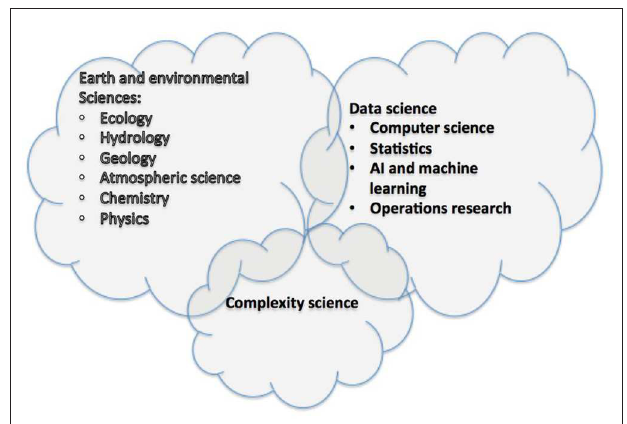
FIGURE 2 | The cross-disciplinary nature of environmental data